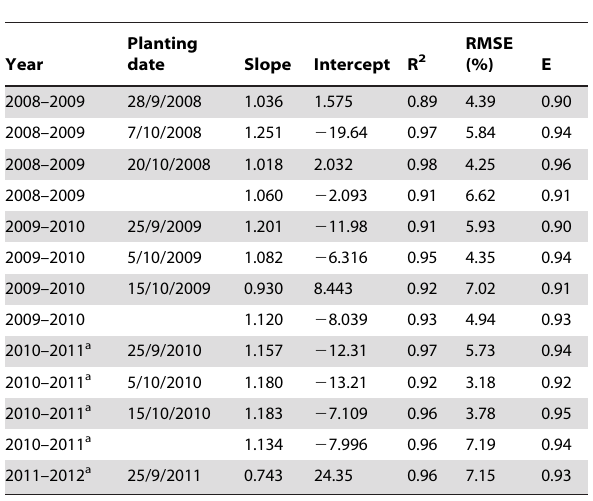
coefficients (stomata closure, leaf expansion, canopy senescence, Table 5. Simulated and measured canopy cover (CC) for